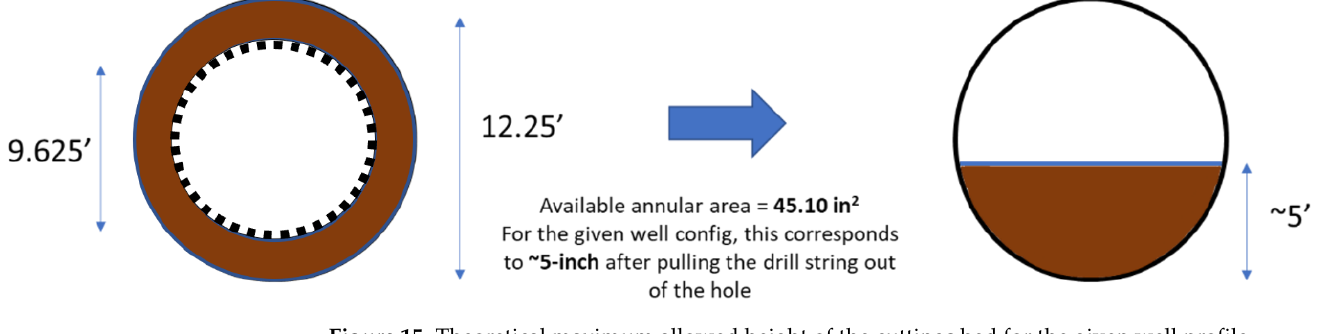
Figure 15. Theoretical maximum allowed height of the cuttings bed for the given well profile.